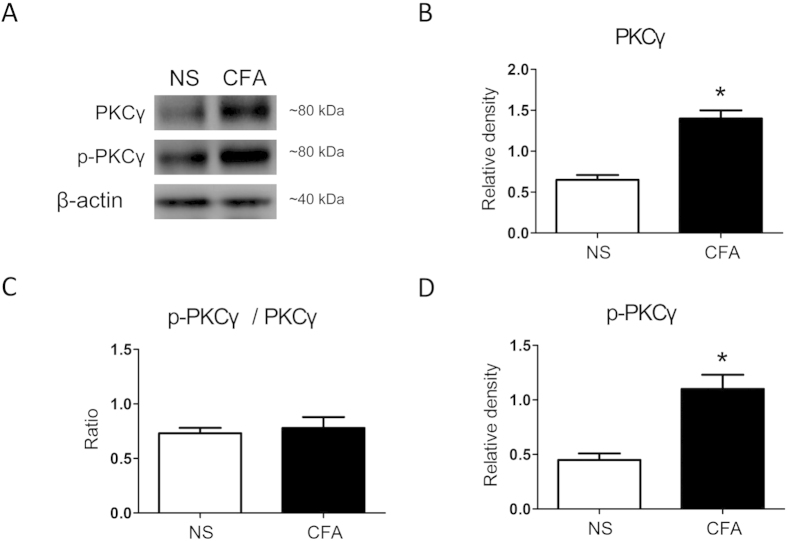
Upregulation of PKCγ expression in the ARC induced by peripheral inflammation.(A) Representative immunoblots against anti-PKCγ, anti-p-PKCγ, and anti-β-actin antibodies (n = 3 for each group). (B) The relative level of PKCγ protein was significantly higher in the CFA group than in the NS group (*p < 0.05, n = 3 for each group). (C) The relative level of p-PKCγ protein was markedly higher in the CFA group than in the NS group (*p < 0.05 vs. NS, n = 3 for each group). (D) The ratio of p-PKCγ/PKCγ remained unchanged after CFA injection. All experiments were repeated at least twice.